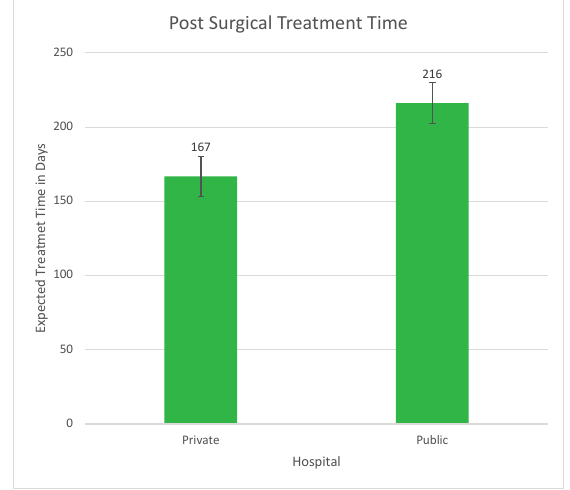
Figure 7. Post-surgical treatment time in private compared to public environment dependent on extraction or non-extraction treatment.